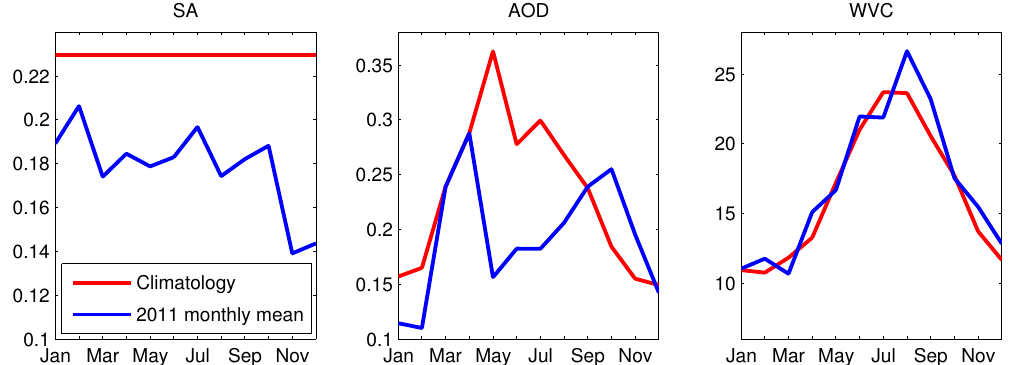
Figure 3. Comparison between climatological and observed / estimated 2011 monthly mean values for surface albedo, aerosol optical depth and water vapor content (in mm) for Uccle